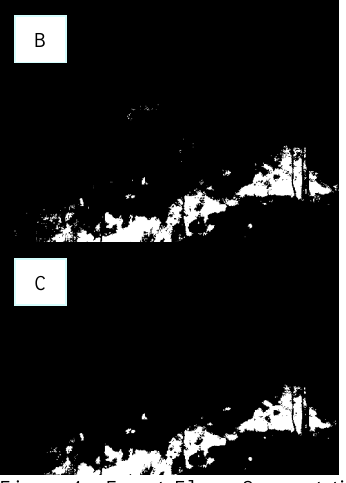
Figure 4 Forest Flame Segmentation Results Based on K- Means Clustering Method(A: forest flame original image; B,C:the result of the division of forest flames for K 5 and